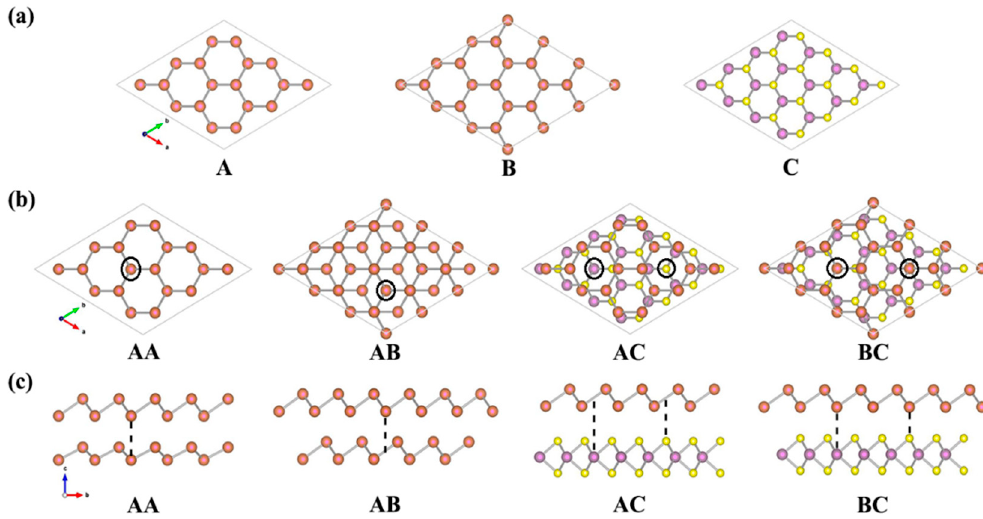
Figure 1. (Color online) ( a ) Top view of the antimonene and MoS 2 monolayer; ( b ) top view and ( c ) side view of the bilayer antimonene and the Sb / MoS 2 hetero-bilayer. Sb, Mo and S atoms are represented by red, purple and yellow balls, respectively.